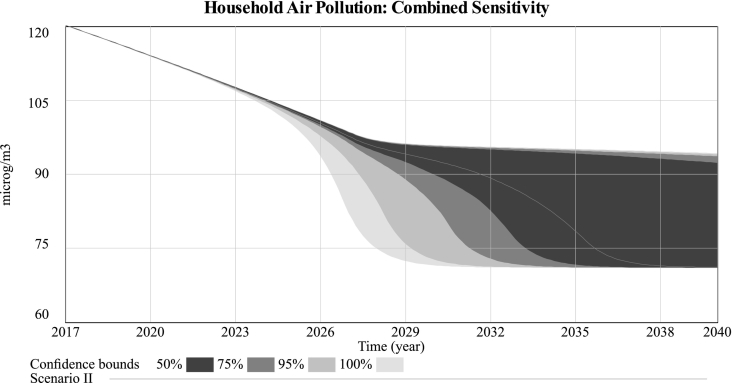
Sensitivity of household air pollution to public concern delay and expenditure growth rate multiplier.